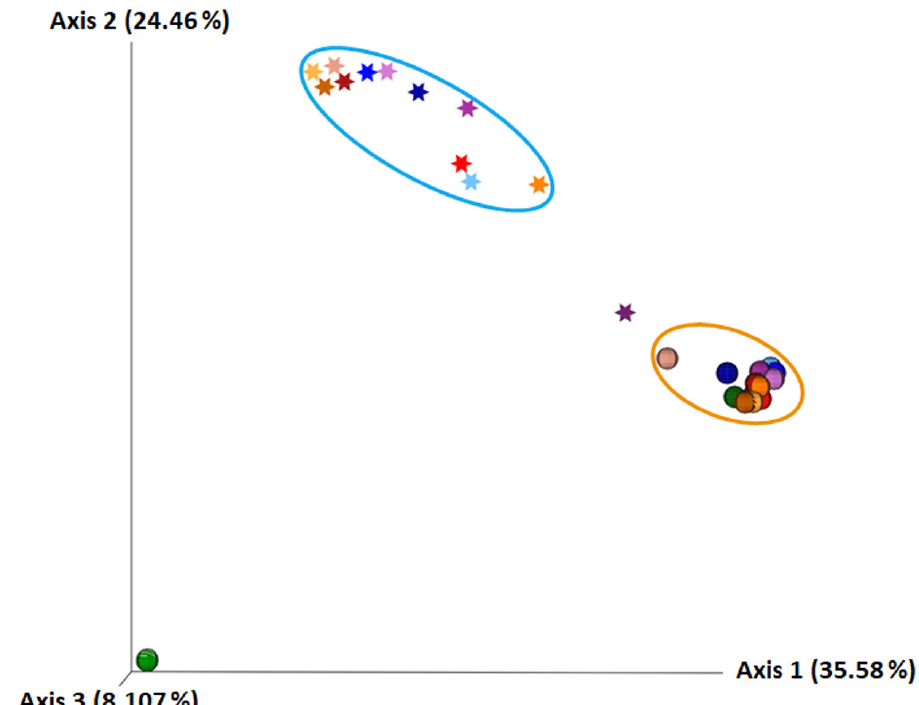
Figure 5. PCoA analysis of β -diversity calculated with the Unweighted UniFrac metric. Human milk samples are represented by an asterisk and faecal samples by a circle. Samples from the same pair of mother and breastfed infant are marked with the same colour, with the samples with the lightest shading of each colour collected within one week after birth, with the medium shading one month after birth, and with the darkest shading one month after the introduction of solid food into the infant diet. The blue ellipse surrounds a cluster of human milk samples, whereas the orange ellipse surrounds a cluster of infant faecal samples.